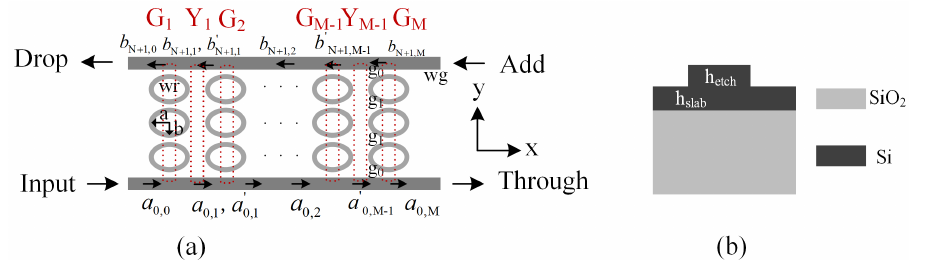
Figure 1. ( a ) Schematic configuration of the optical filter based on the 3 × 20 arrays. ( b ) Waveguide cross